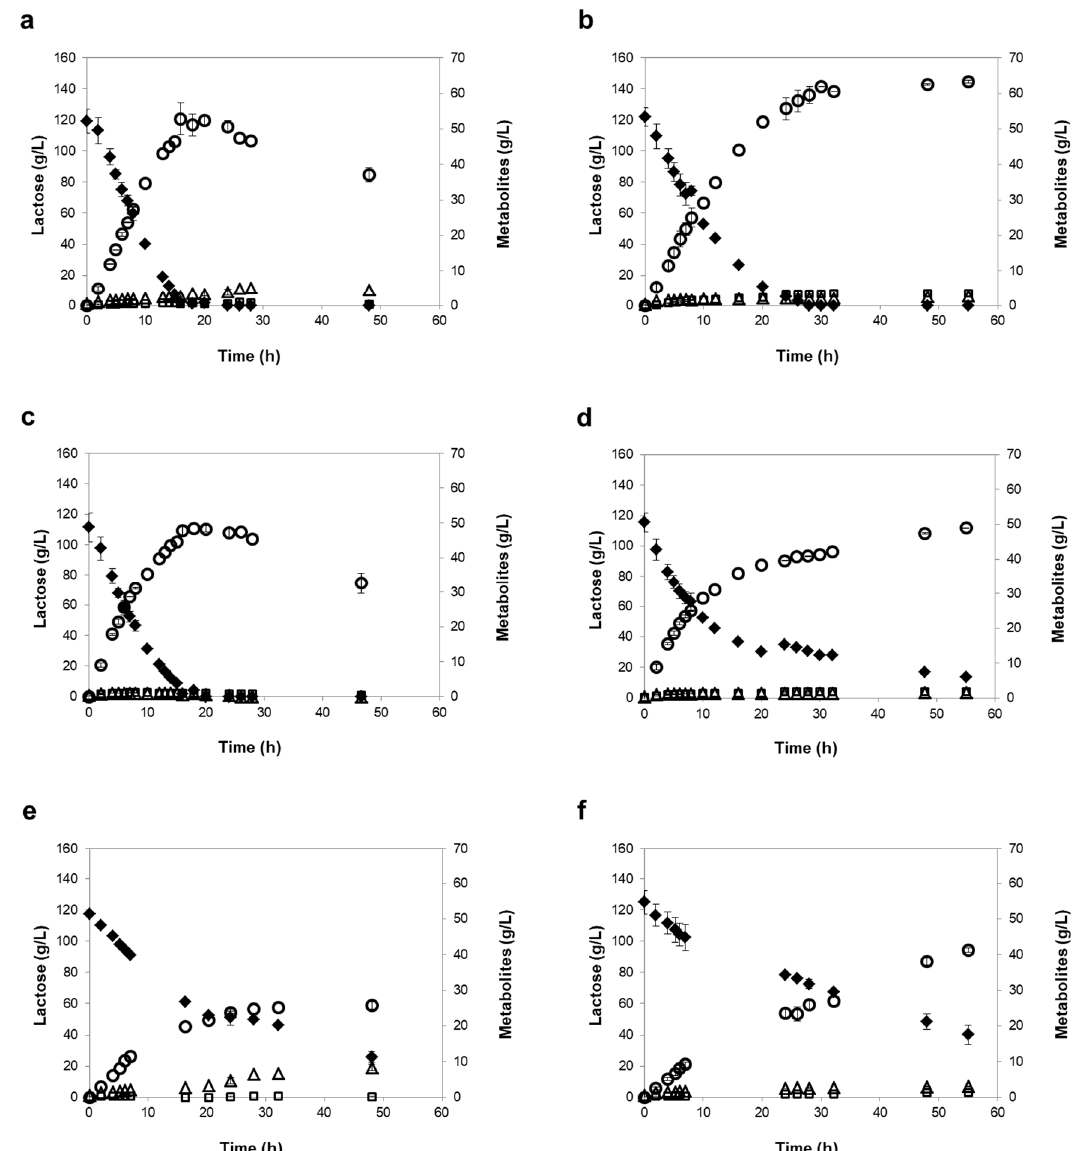
Figure 2. Fermentation profiles of the K. marxianus PYCC 3286 strain ( a , b ), the K. lactis PYCC 4356 strain ( c , d ), and the K. marxianus CBS 397 strain ( e , f ), in NF media, in mild oxygen-limiting conditions (left panels) and severe oxygen-limiting conditions (right panels). Lactose ( ), ethanol ( ), glycerol ( ), and acetic acid ( ). Error bars represent standard deviation from the average value of three independent experiments.